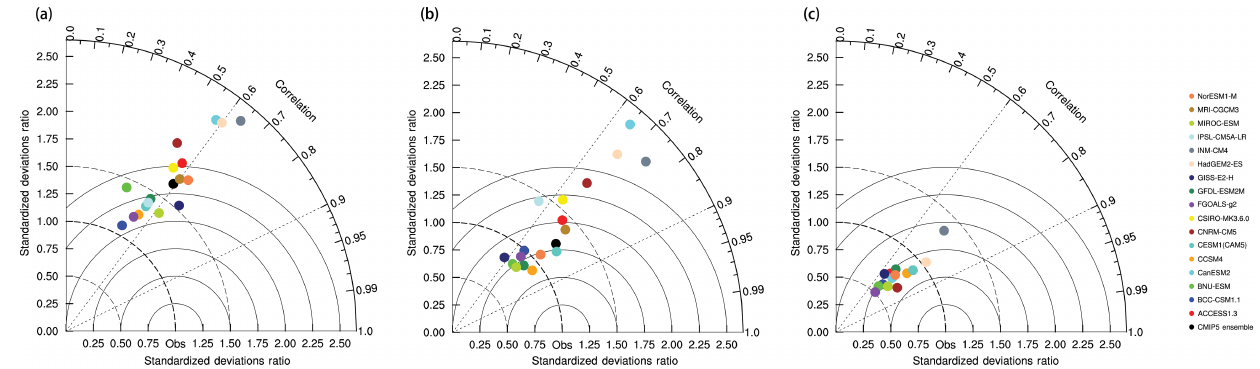
Figure 7. Taylor diagrams for the CMIP5 models based on the (a) ECV satellite data, (b) in situ observations in the 0–10cm layer and (c) in situ observations in the 0–100cm layer. The azimuthal angle represents the correlation coefficient, and radial distance is the standard deviation normalized to